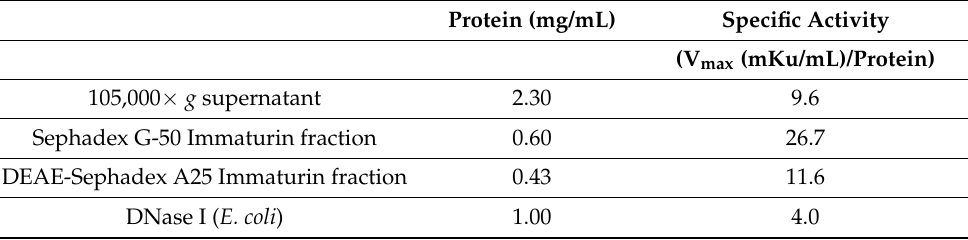
Table 2. DNase I enzyme assay of